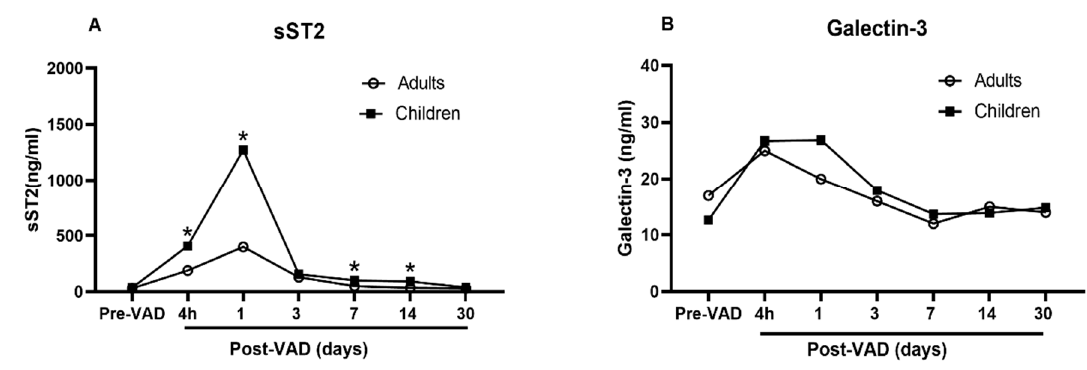
Figure 2. Comparison of sST2 and galectin-3 between adults and children undergoing VAD. Redrawn based upon data reported in [15]. ( A ) Significantly higher circulating level of sST2 in children than in adults at every time points; ( B ) No difference in the circulating level of galectin-3.